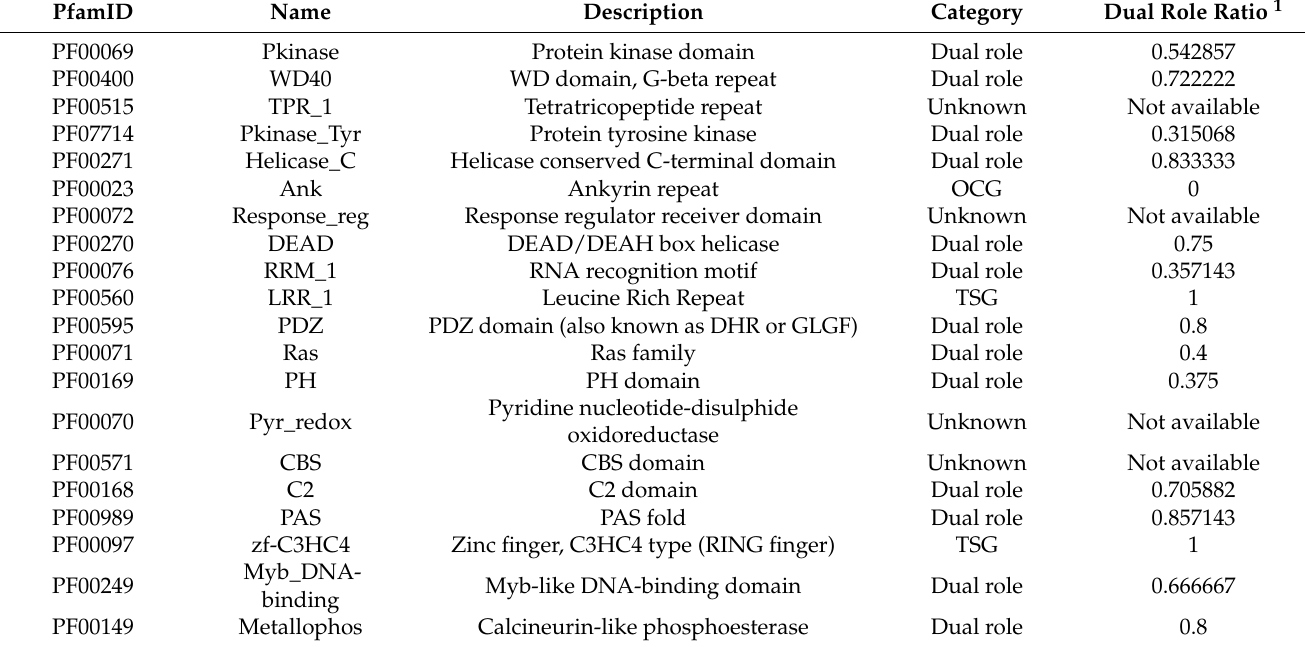
Table 2. The top twenty Pfam domains with the most interactions across 12